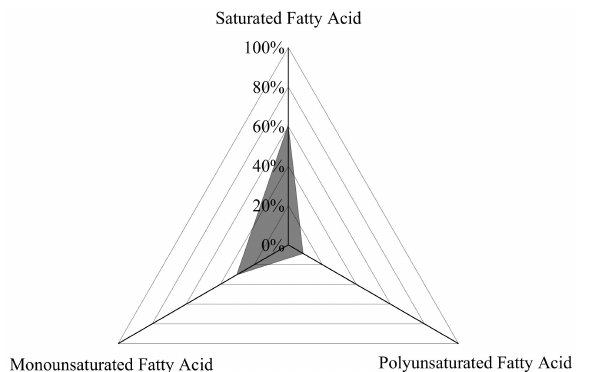
Figure 5. Degree of unsaturation of fatty acid methyl esters (FAMEs) profile in BSFL-based biodiesel fed with various ratios of blended sewage